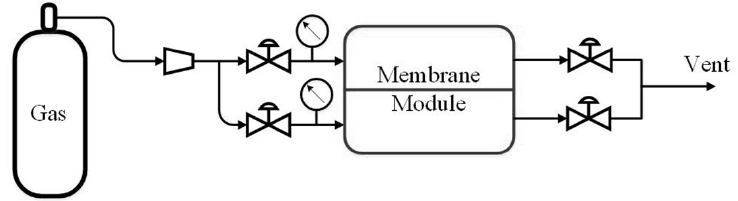
Figure 1. The scheme of the experimental setup for gas separation testing.